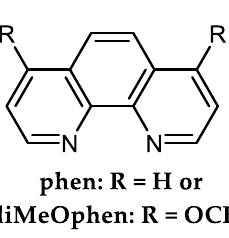
Figure 2. N,N-bidentate nucleophiles effective for Cu-catalyzed C-N cross-coupling [22,56 – 59]. DMEDA or DMCHDA were utilized together with CuI/K 3 PO4 for effective arylation of indoles using Ar-I and Ar-Br in boiling toluene [57].